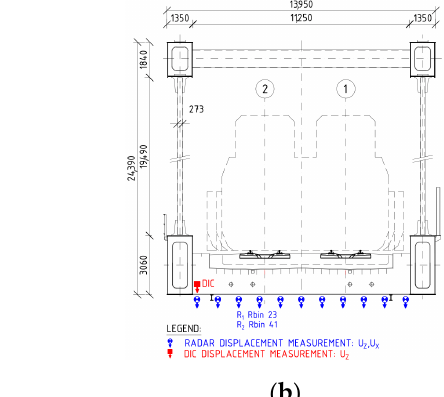
Figure 17. Side view on the analyzed superstructure BS2 ( a ) photo; in the background there is the superstructure BS3; ( b ) schematic with marked positions of DIC target, Rbins, radars, and DIC camera.